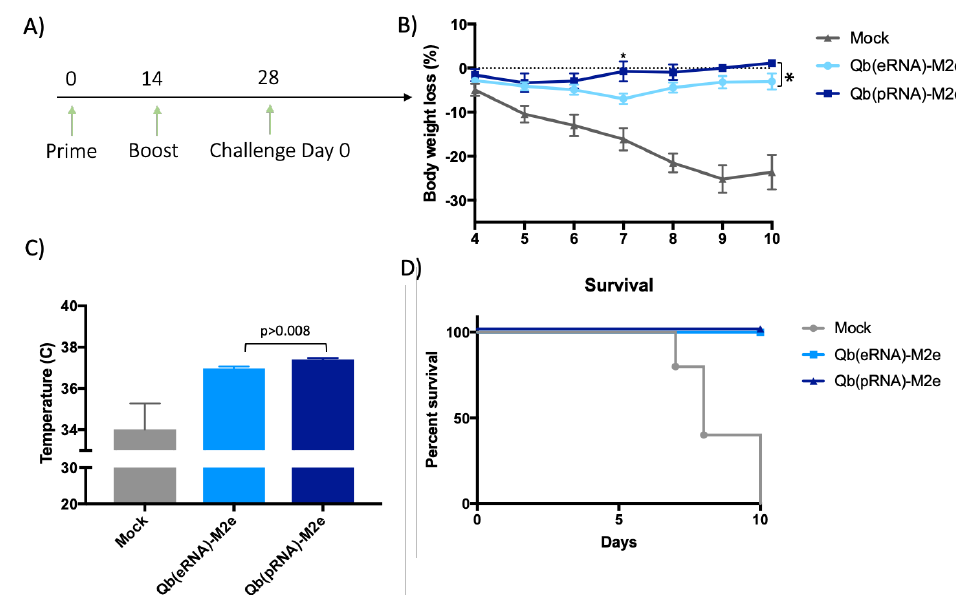
Figure 5. Reduced morbidity symptoms of mice immunised with formulations containing prokaryotic RNA in an influenza challenge. ( A ) Immunisation and challenge schedule. 8–12 weeks female BALB / c